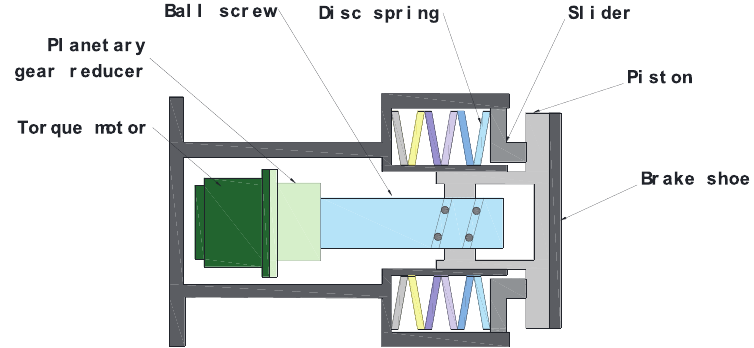
Fig. 1. Structural diagram of electro-mechanical